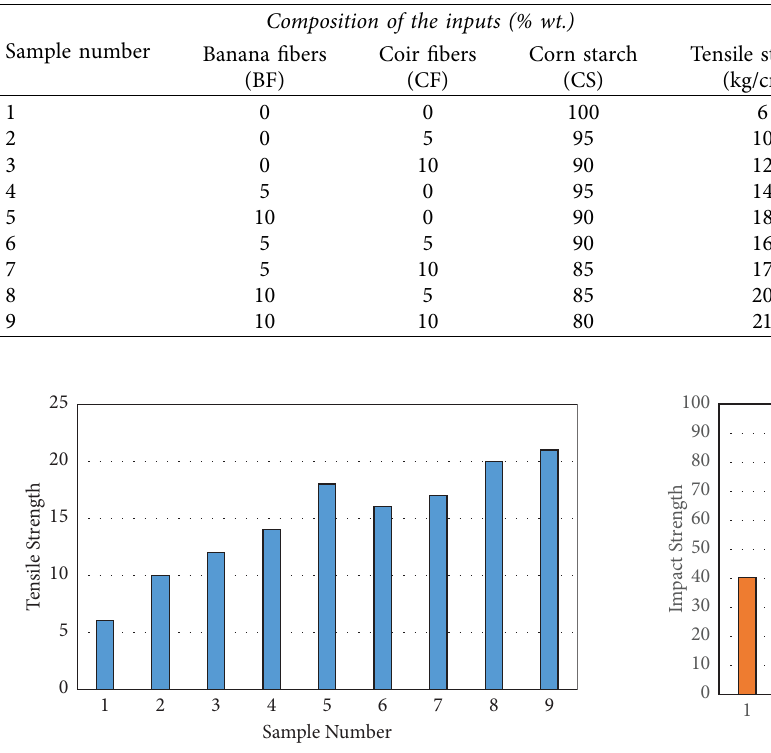
Figure 3: Variation in tensile strength against the varying wt. % of natural fibers.